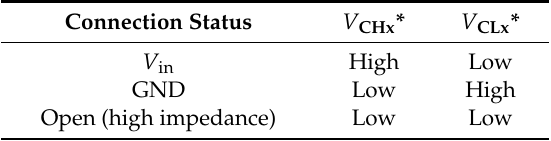
Table 2. Relationship between actuator’s connection status and control signals.